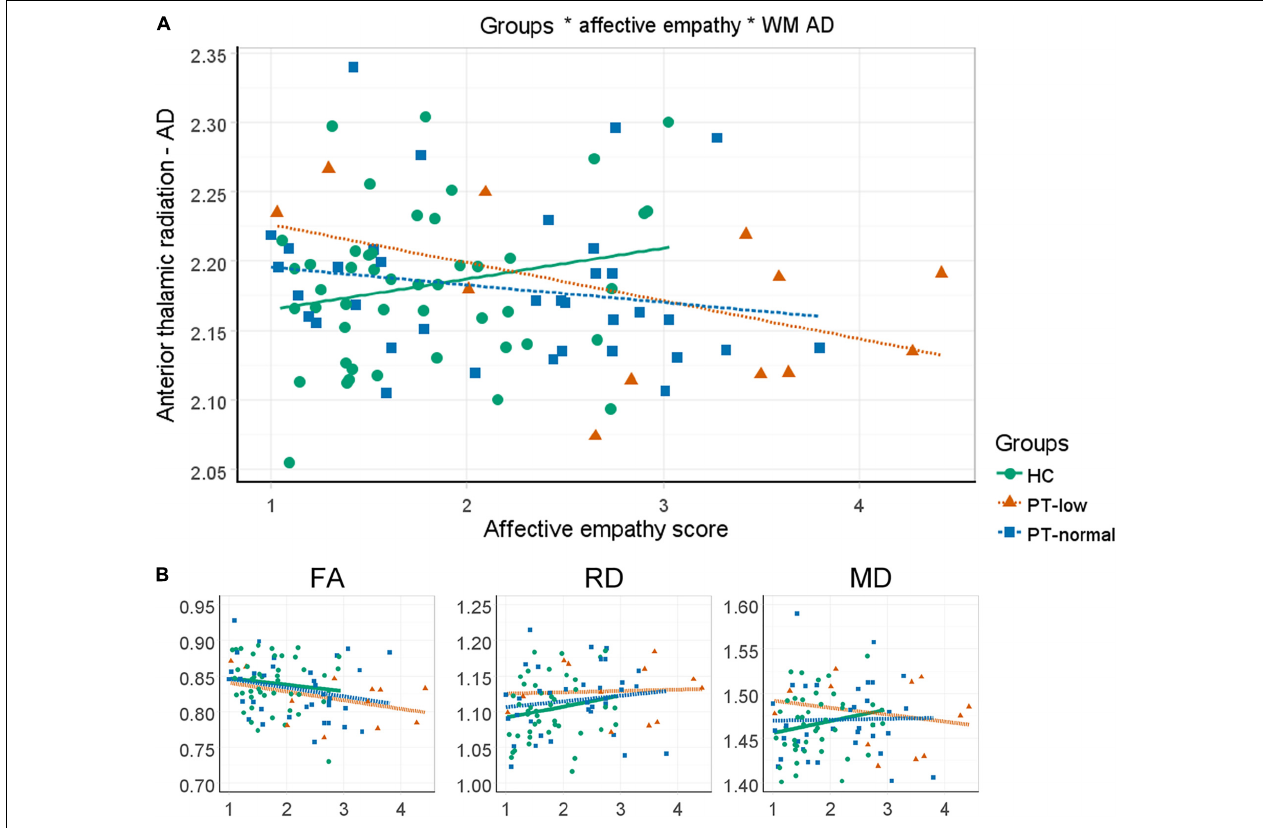
FIGURE 5 | Three-way interactions between emotion recognition, affective empathy and white matter diffusivity measures. (A) Anterior thalamic radiation AD*1000 is plotted against affective empathy in healthy controls (green circles/solid line) and patients with normal (blue squares/large dashed line) and low (orange triangles/small dashed line) performance on emotion recognition. Dots are raw values; lines are linear fitted trendlines. (B) Similar plots but now for RD*1000, FA and MD*1000 in the anterior thalamic